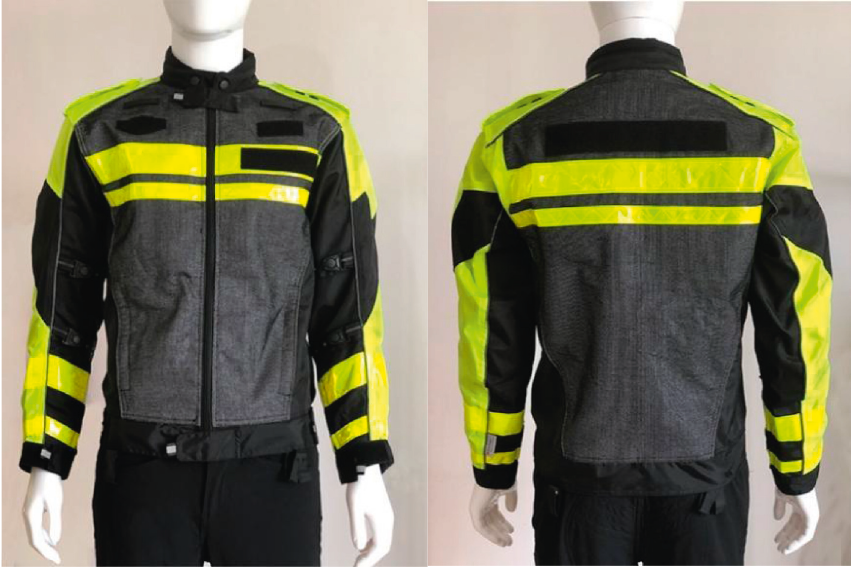
Figure 6: Chinese traffic police clothing.